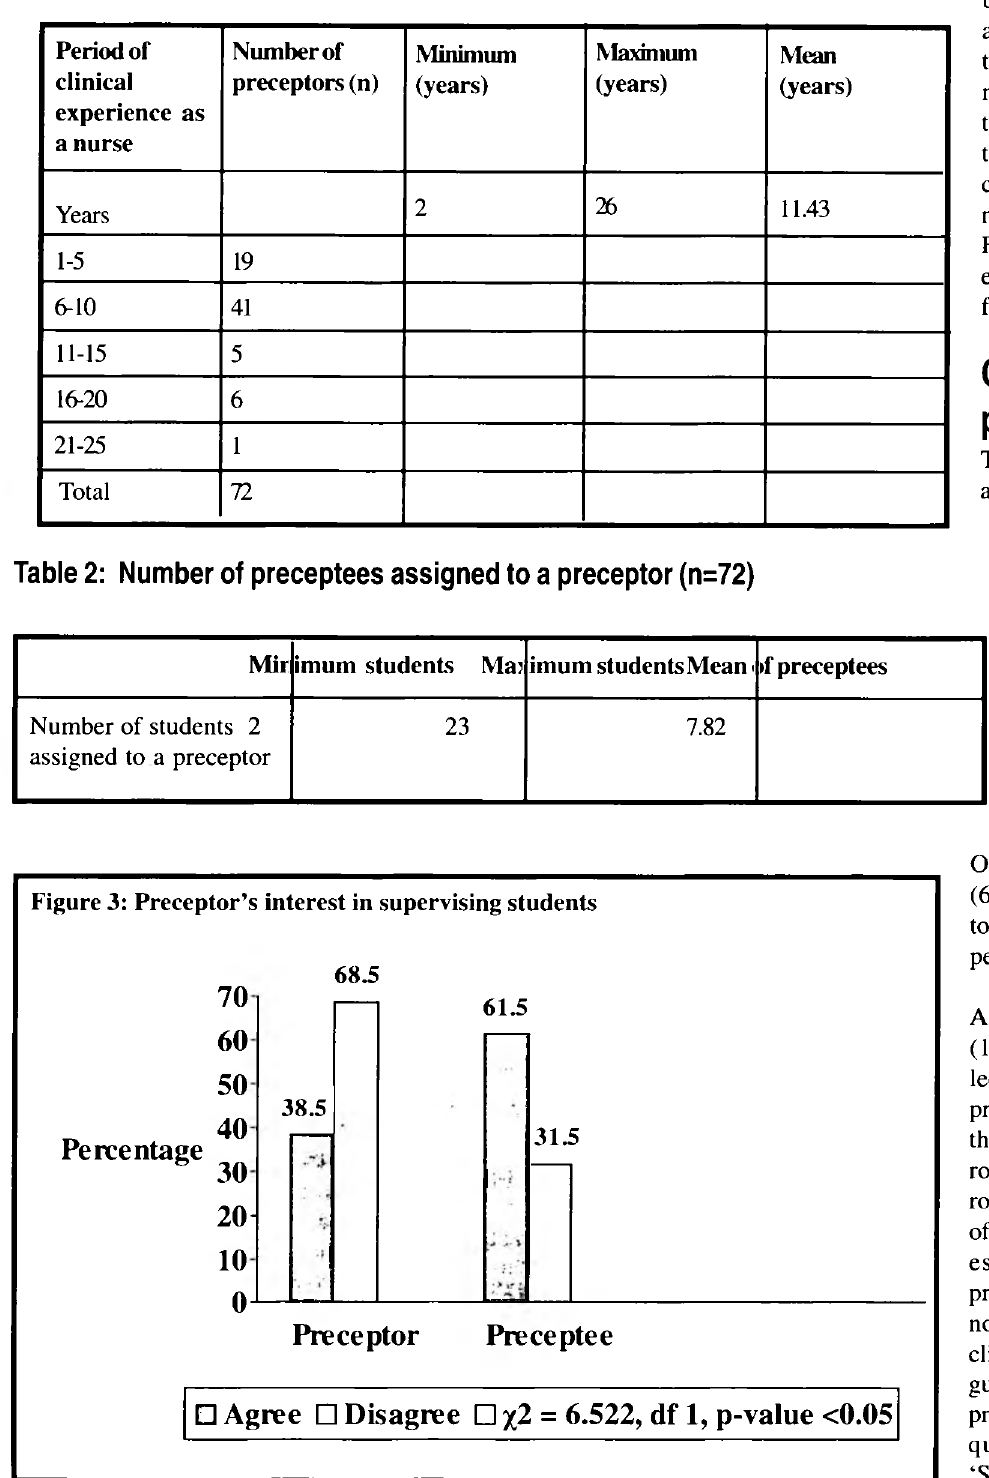
Figure 3: Preceptor’s interest in supervising